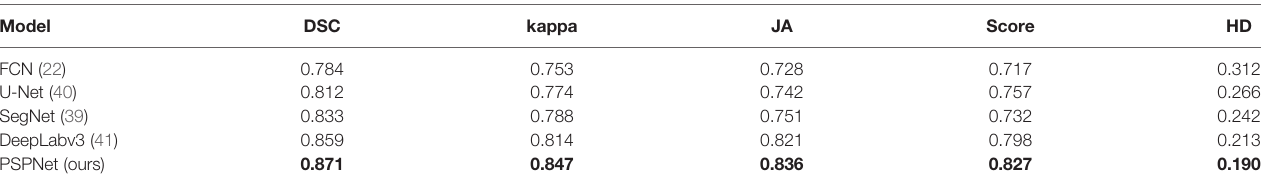
Bold values represents the best performance.